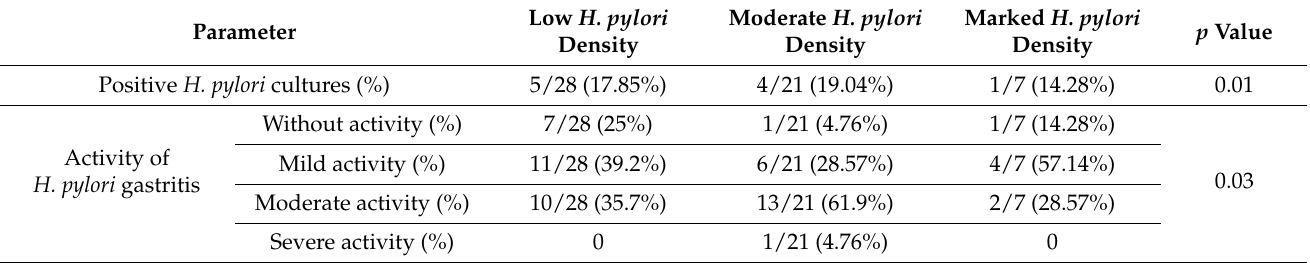
Table 3. Correlation between H. pylori density in the histological examination, positive bacterial cultures, and the activity of associated